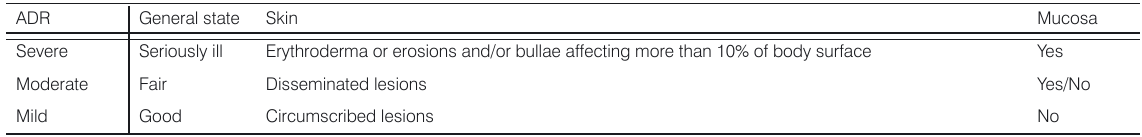
Table 1. Definitions of ADR severity levels.